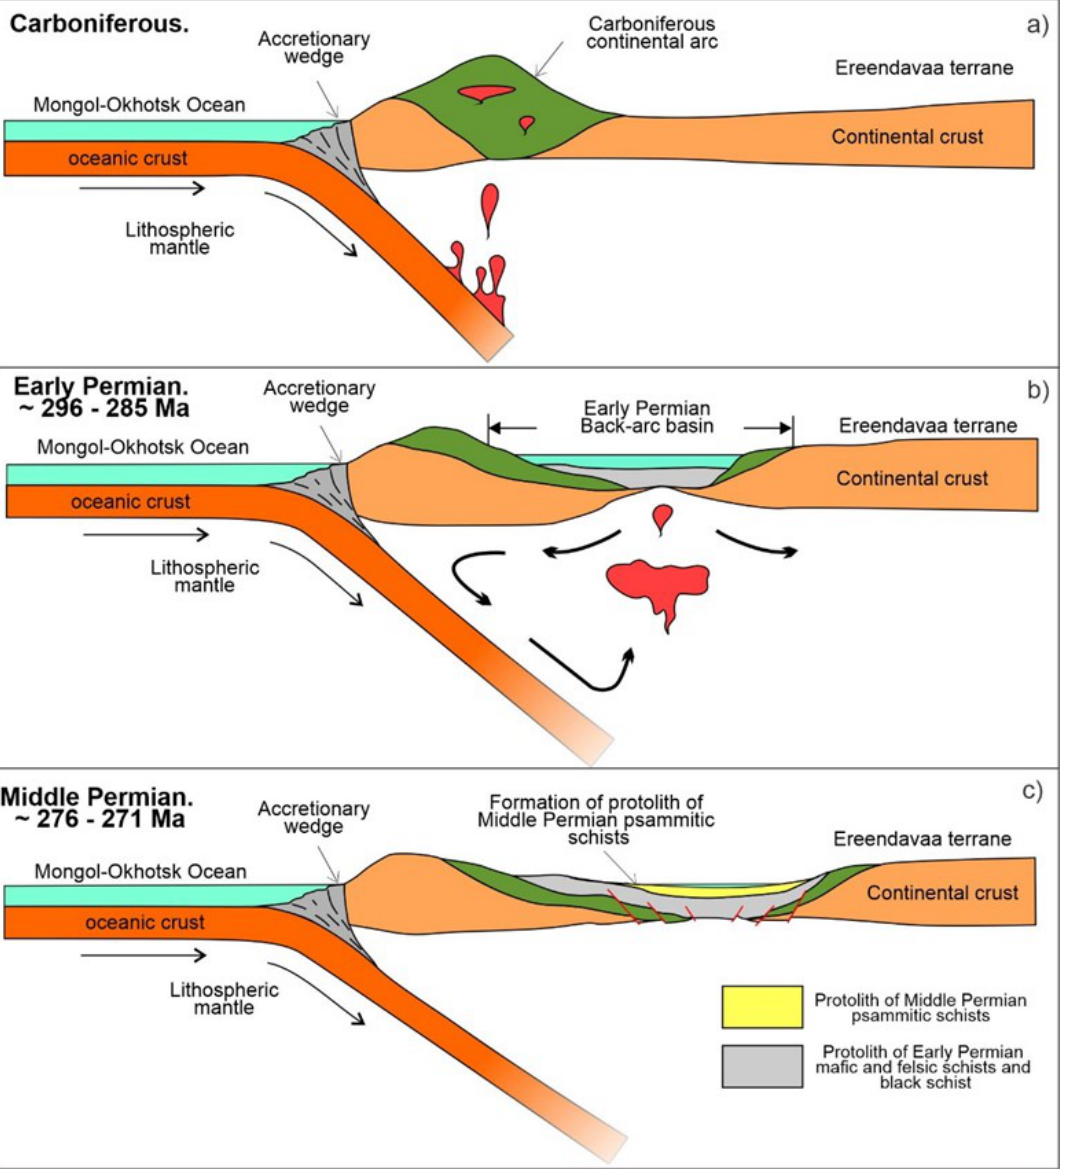
Fig. 14. Simplified scheme showing a geodynamic evolution model for the Ereendavaa terrane, Eastern Mongolia during the Early-Middle